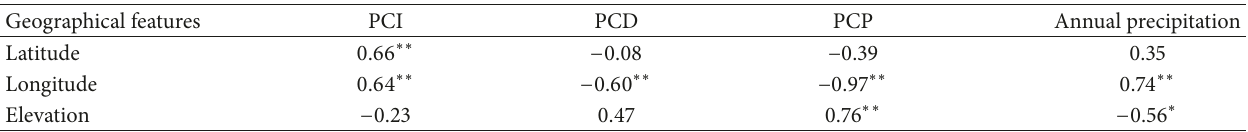
Table 4: Pearson’s correlation coefficients between the geographical features of the UHRB, precipitation indices (PCI, PCD, and PCP) and annual